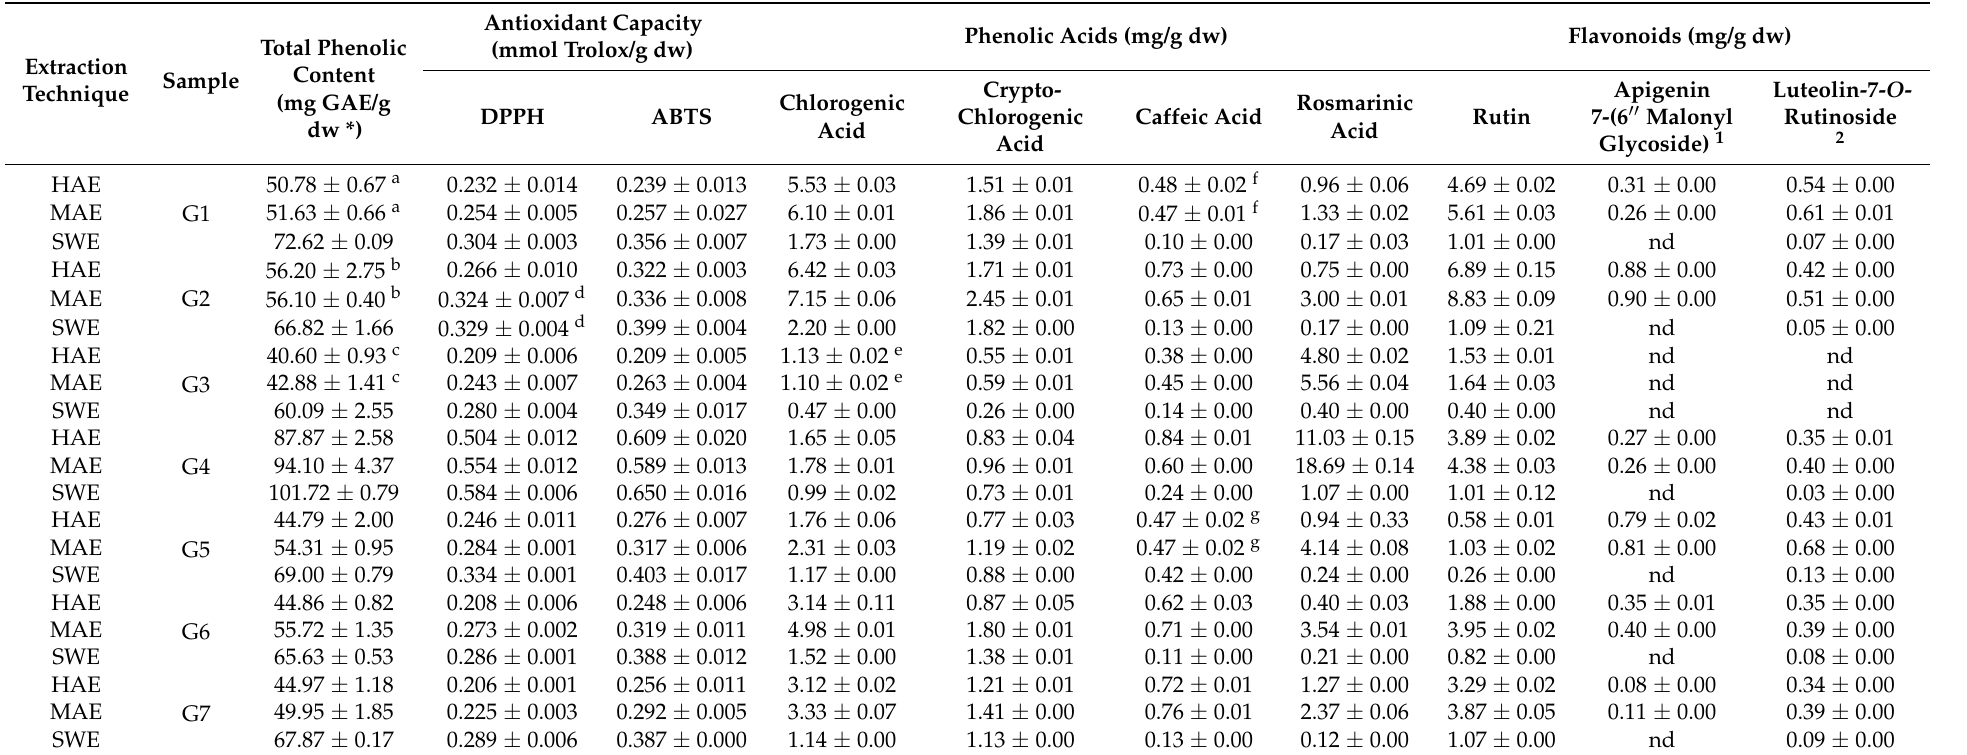
Table 3. Total phenolic content (TPC), antioxidant capacity and content of individual phenolic compounds in ground